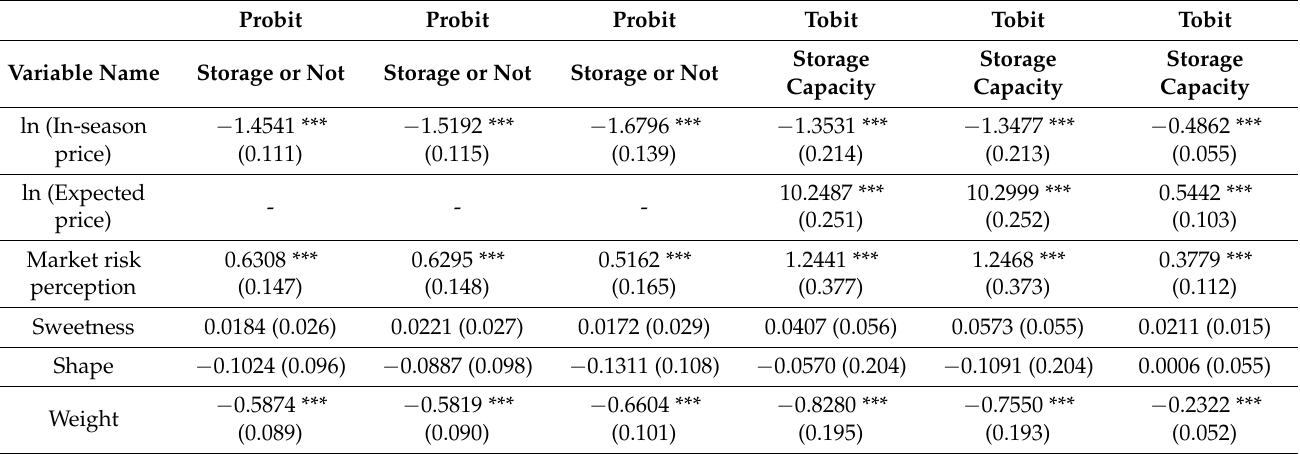
Table 3. Benchmark regression results for growers’ storage decision